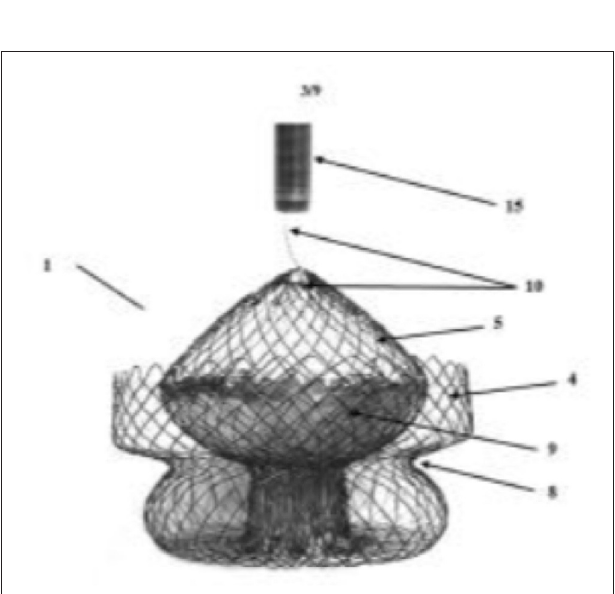
FIGURE 7 | Tri-cares valve. Schematic diagram of self-expanding prosthesis made from bovine pericardial tissue mounted on a nitinol stent